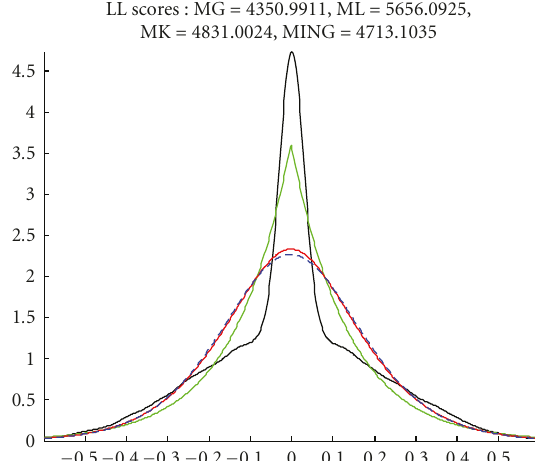
Figure 7: Two-part discrete mixture of Gaussians (black) fitted as Laplacian (green), K-distribution (red) and normal inverse Gaussian (blue dashed). The mixture appears to have a high non- Gaussianity measure.